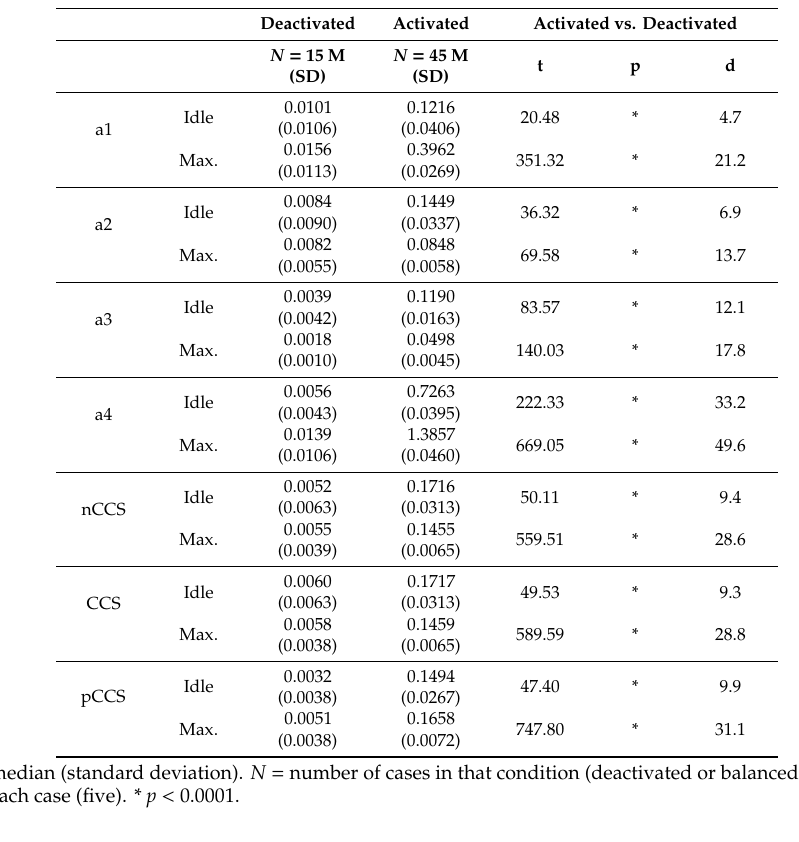
Table 6. Sample description and statistical comparison of the peak amplitudes of the sieve box in the individual spectra (a1–4) and the non-coherent (nCCS), coherent (CCS), and poly-coherent (pCCS) composite spectra, under di ff erent working conditions (deactivated, activated) and speeds (at idle and at max. RPM).